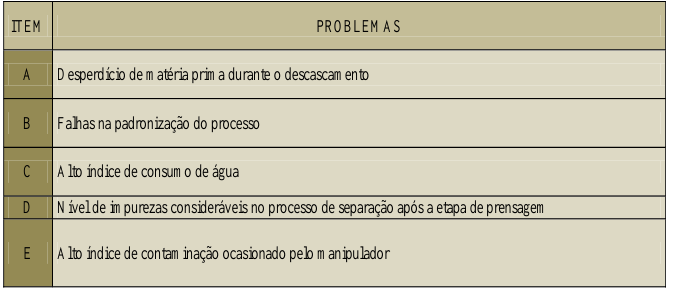
Tabela 6: Relação dos problemas e itens correspondentes.